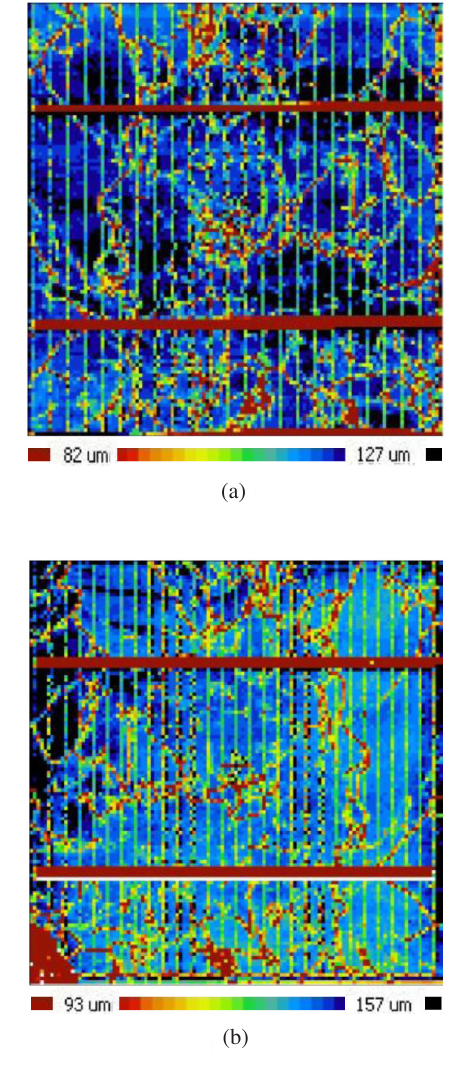
Figure 5. Two-dimensional distribution of the minority carrier diffusion length in (a) n + pn + and (b) n + pp + solar cells.